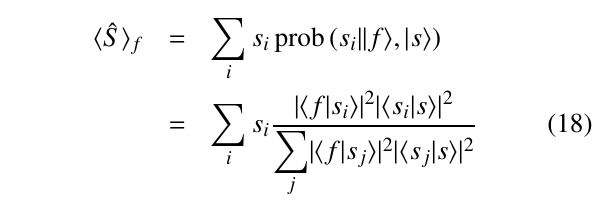
of the eigenstates | s i (cid:105) , i = 1 , 2 , . . . , d S , of the operator ˆ